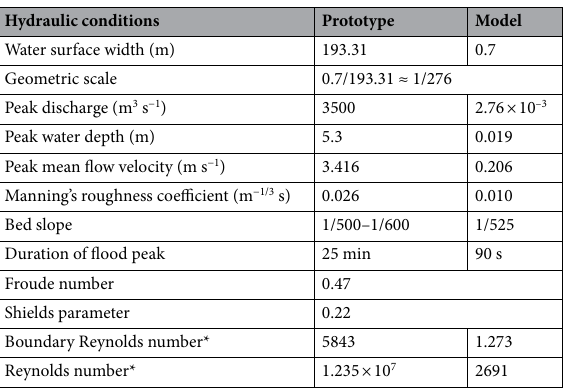
Table 1. Experimental specifications. *Calculated using kinematic viscosity coefficient at water temperature of 8